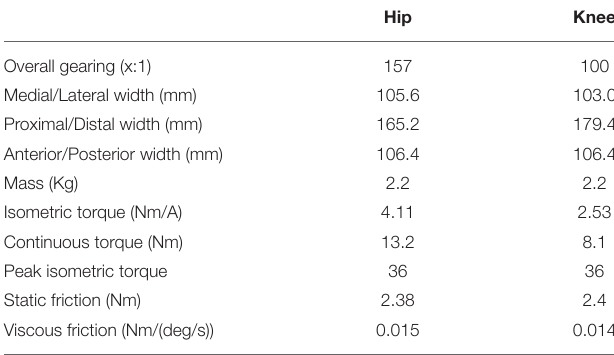
TABLE 1 | Power unit parameter